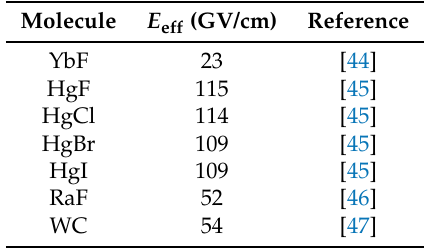
Table 1. E eff for some candidate molecules that could be used with the EDM 3 method. Other molecules, including chlorides and oxides, would also be suitable for EDM 3